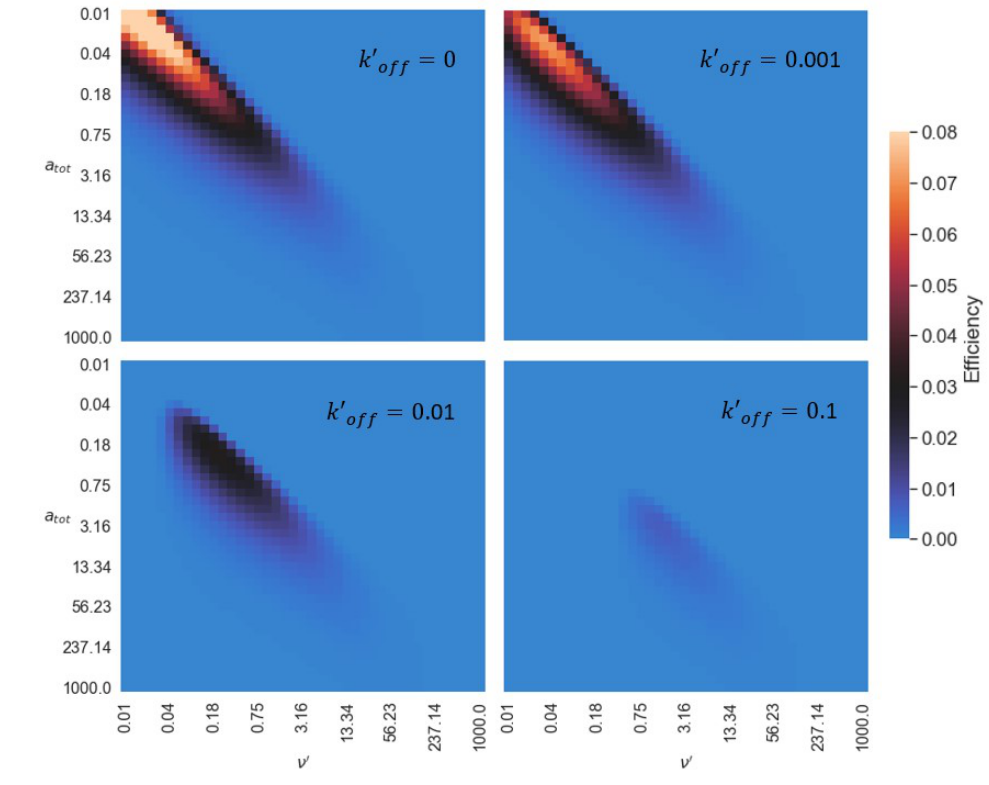
Figure 5. Effects of rebinding on efficiency. Efficiency heat maps for different k (cid:48) calculations, ω (cid:48) = 0, ∆ g =